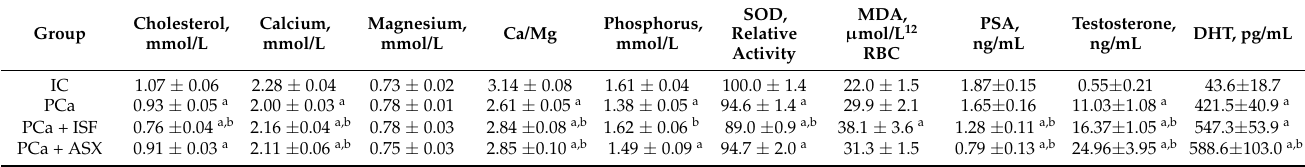
Table 4. Serum biochemistry in rats with prostate carcinogenesis treated with ISF and